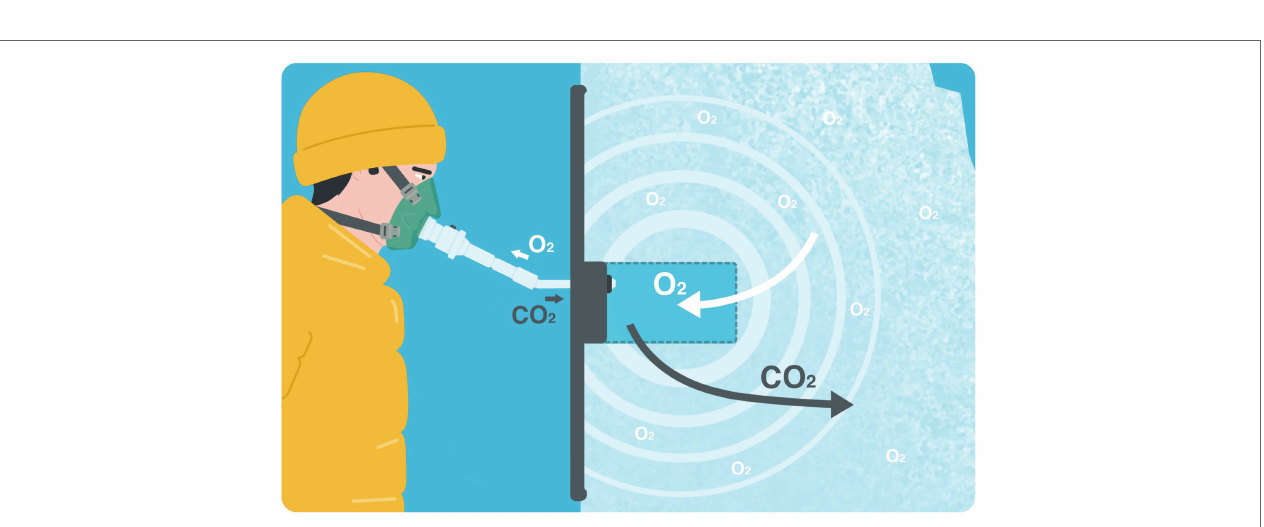
FIGURE 5 | Breathing into an artificial snow avalanche. The porosity of the snow allows diffusion of O 2 from snow debris into the air pocket and diffusion of exhaled CO 2 into the surrounding snow. CO 2 , carbon dioxide; O 2 , oxygen (Illustration by Dalila Rovazzani. All rights reserved, used with